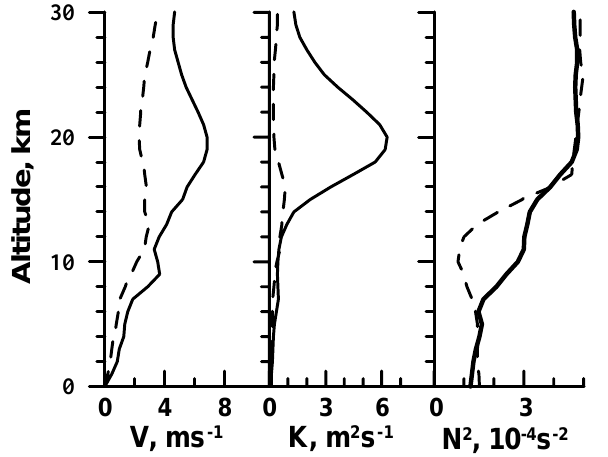
Fig. 4. Calculated vertical profiles of IGW horizontal velocity stan- dard deviation (left), turbulent viscosity (middle) and Brunt-V¨ais¨al¨a frequency squared (right) for January (solid lines) and July (dashed lines) at Shigaraki.